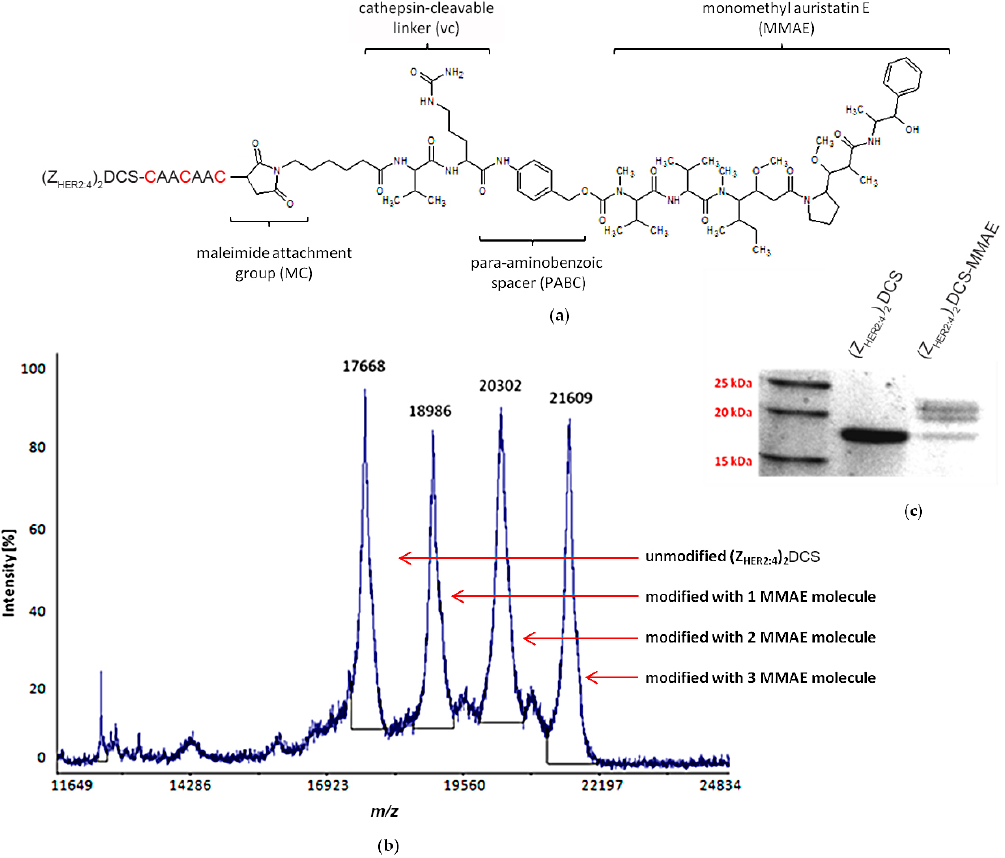
Figure 5. (Z HER2:4 ) 2 DCS conjugation with MC-Val-Cit-PABC-MMAE (monomethyl-auristatin